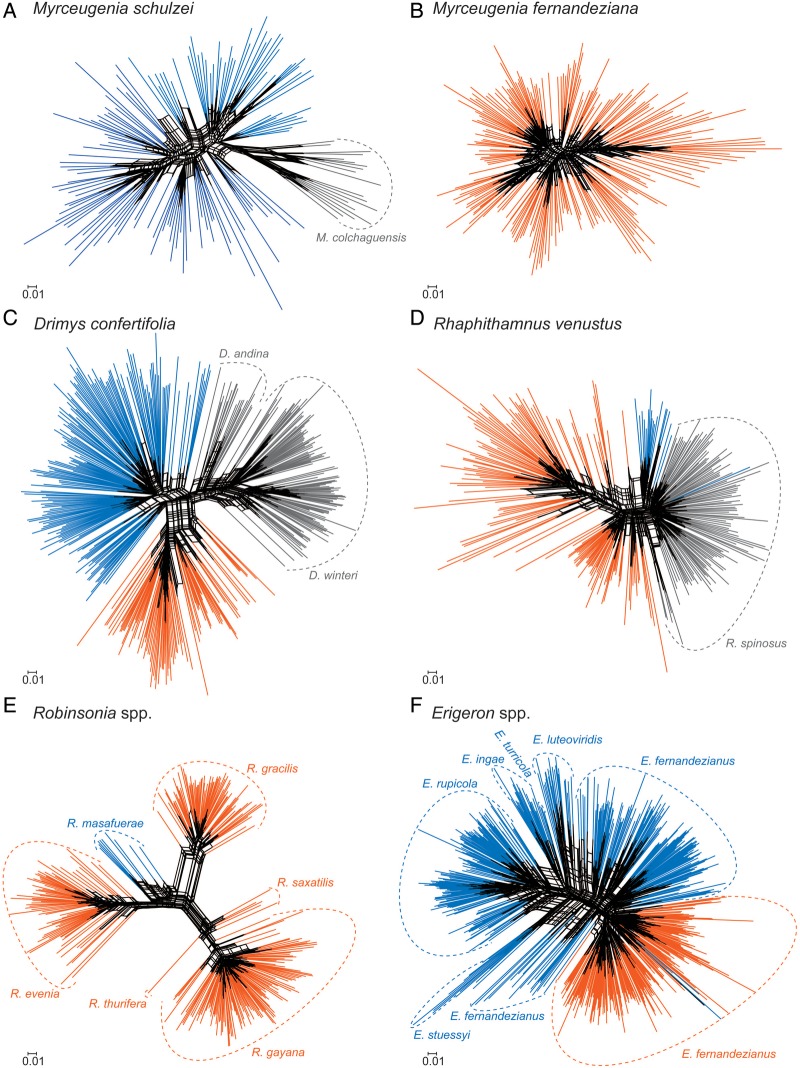
SplitsTree NeighborNet showing genetic relationships based on AFLPs among individuals in endemic species of Myrceugenia (A and B), Drimys (C), Rhaphithamnus (D), Robinsonia (E) and Erigeron (F) in the Juan Fernández Archipelago. Closely related continental relatives are also shown in A, C and D. Orange = species and populations on Robinson Crusoe Island; blue = on Alejandro Selkirk Island and black = on the or islands continent.